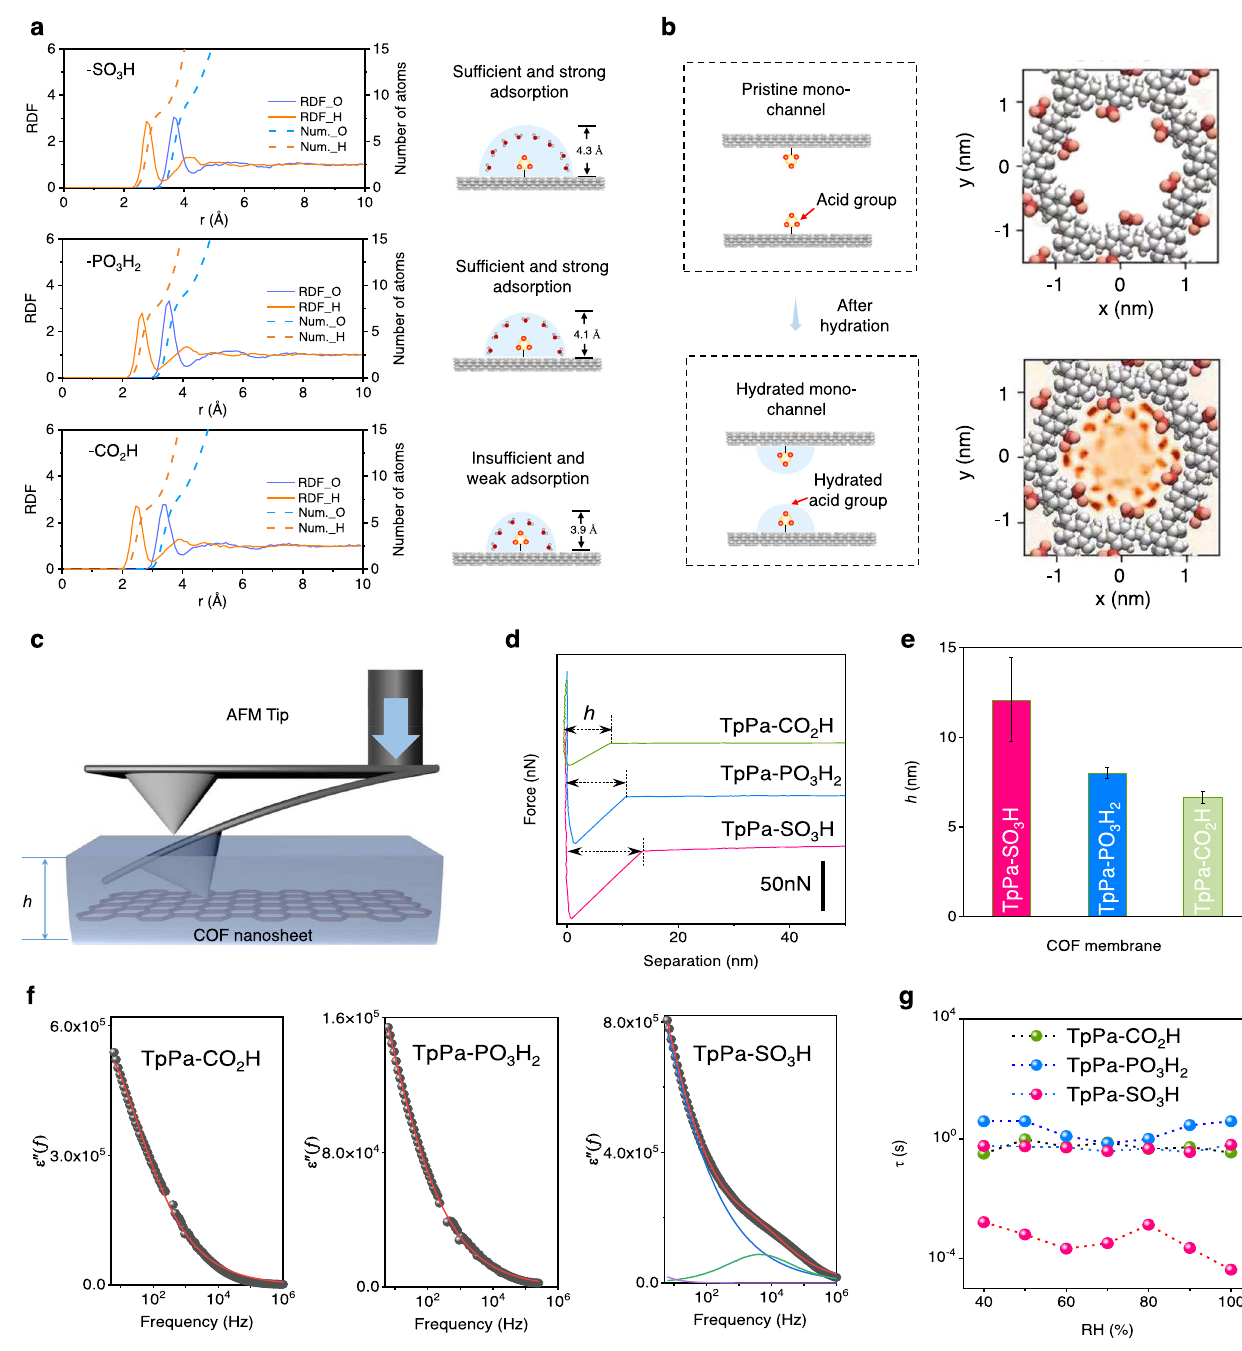
Fig. 4 | Simulations and characterizations on hydration shells of COF mem- branes. a Simulation on the structures of hydrated acid groups. b Schematic illustrationofhydrated acidgroupsinCOFmembranes. c Principle ofcontactAFM measurements for the evaluation of con fi ned water layer and the scheme of jump- to-contact region corresponding to the con fi ned water layer. d Force-distance curve of variable COF nanosheets deposited on highly oriented pyrolytic graphite. The separation displacement was de fi ned as piezo height minus cantilever de fl ec- tion. e Length of jump-to-contact region of variable COF nanosheets. The Force-